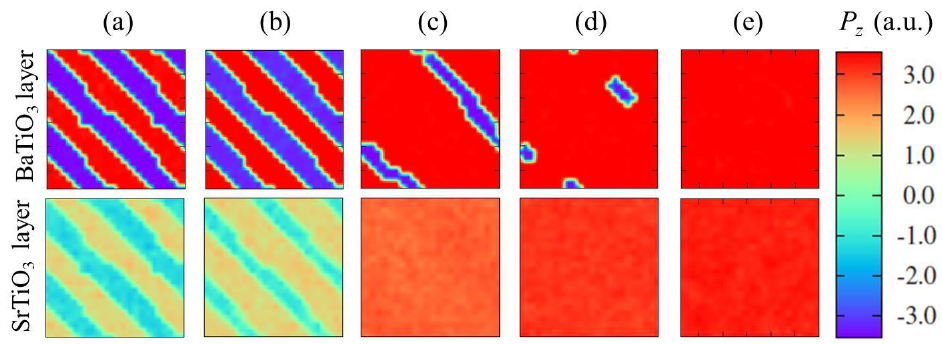
Figure 16. (001) Cross sections of dipole patterns in a BaTiO 3 layer (top row) and SrTiO 3 layer (bottom row) at T = 10 K, in the [BaTiO 3 ] 10 /[SrTiO 3 ] 10 superlattice for different static electric fields: ( a ) E = 0.0 MV/cm; ( b ) E =2.65 MV/cm; ( c ) E = 3.0 MV/cm; ( d ) E = 4.5 MV/cm; and ( e ) E = 5.8 MV/cm. The color reflects the out-of-plane